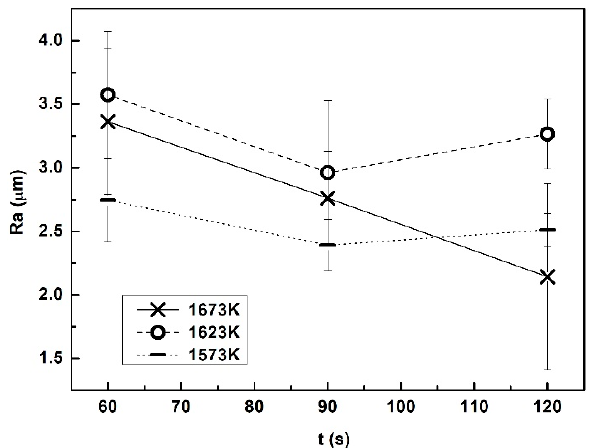
Figure 5. Roughness of film surfaces in contact with the water-cooled copper probe, for films formed in molten flux with different bulk temperatures after different probe immersion times. Error bars give the standard deviations.